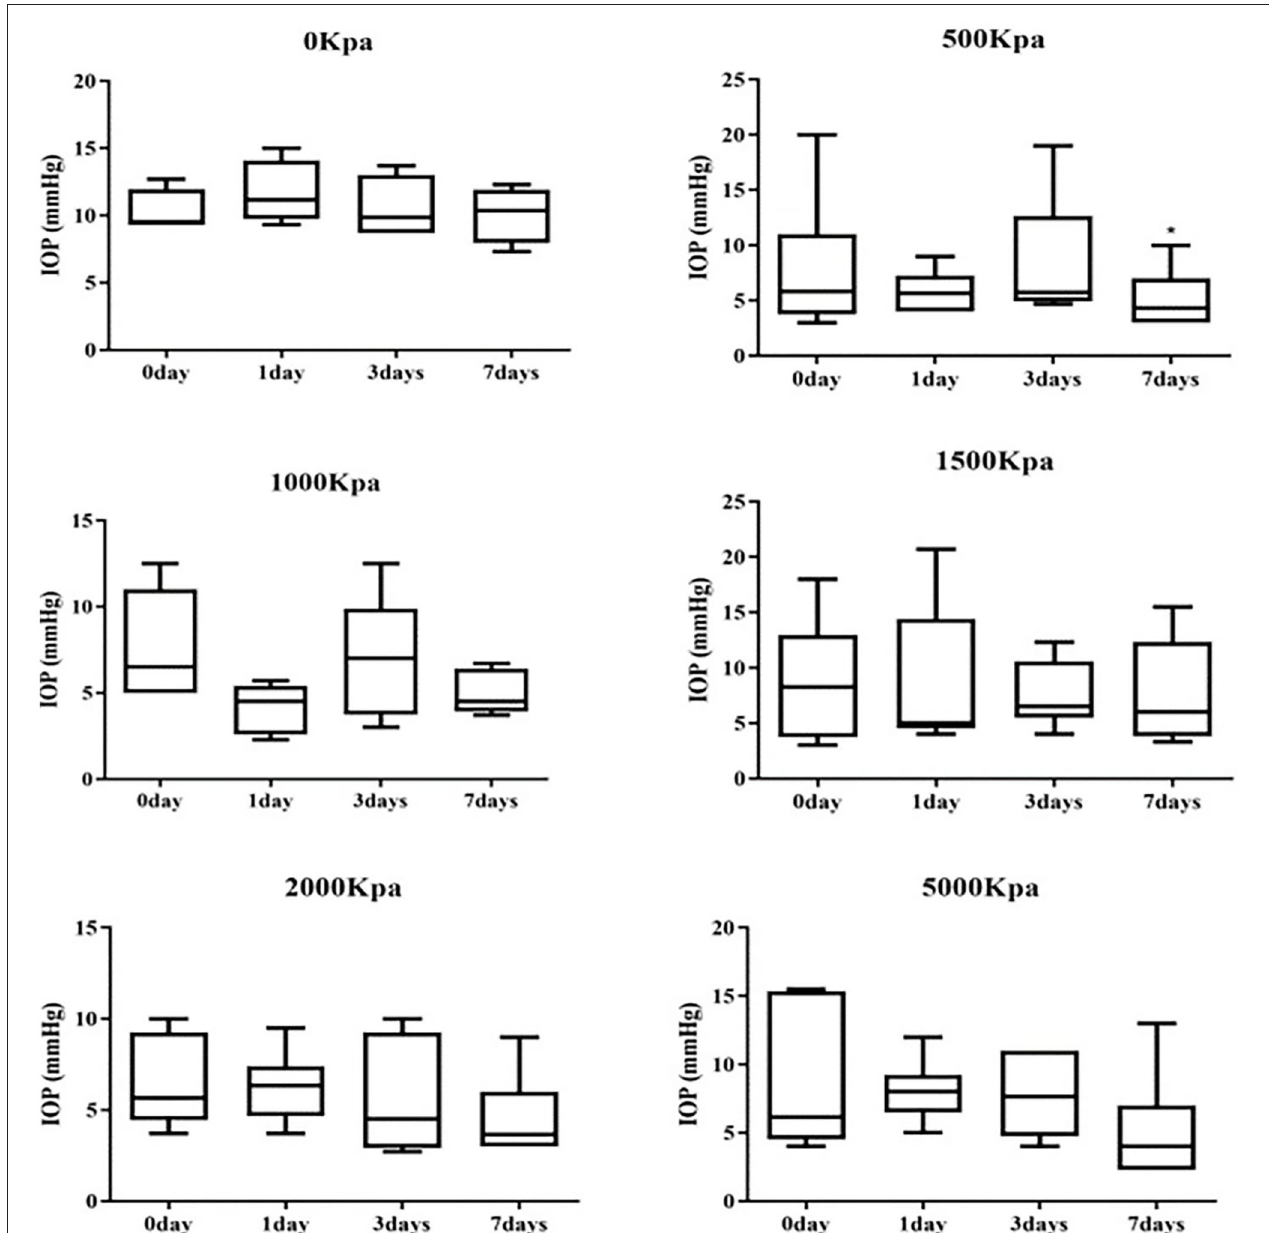
FIGURE 10 | Whisker plot of intraocular pressure (IOP) measured at 0-, 1-, 3-, and 7-days post-blast. *Means P < 0.05 compared with day 3.